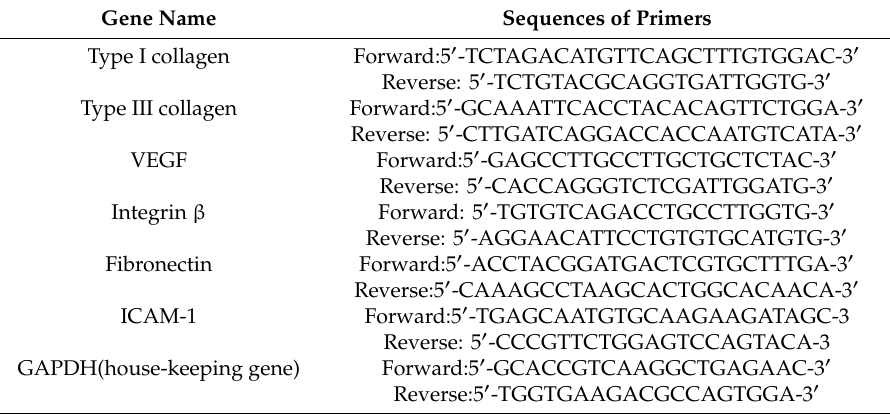
Table 1. Sequences of primers for